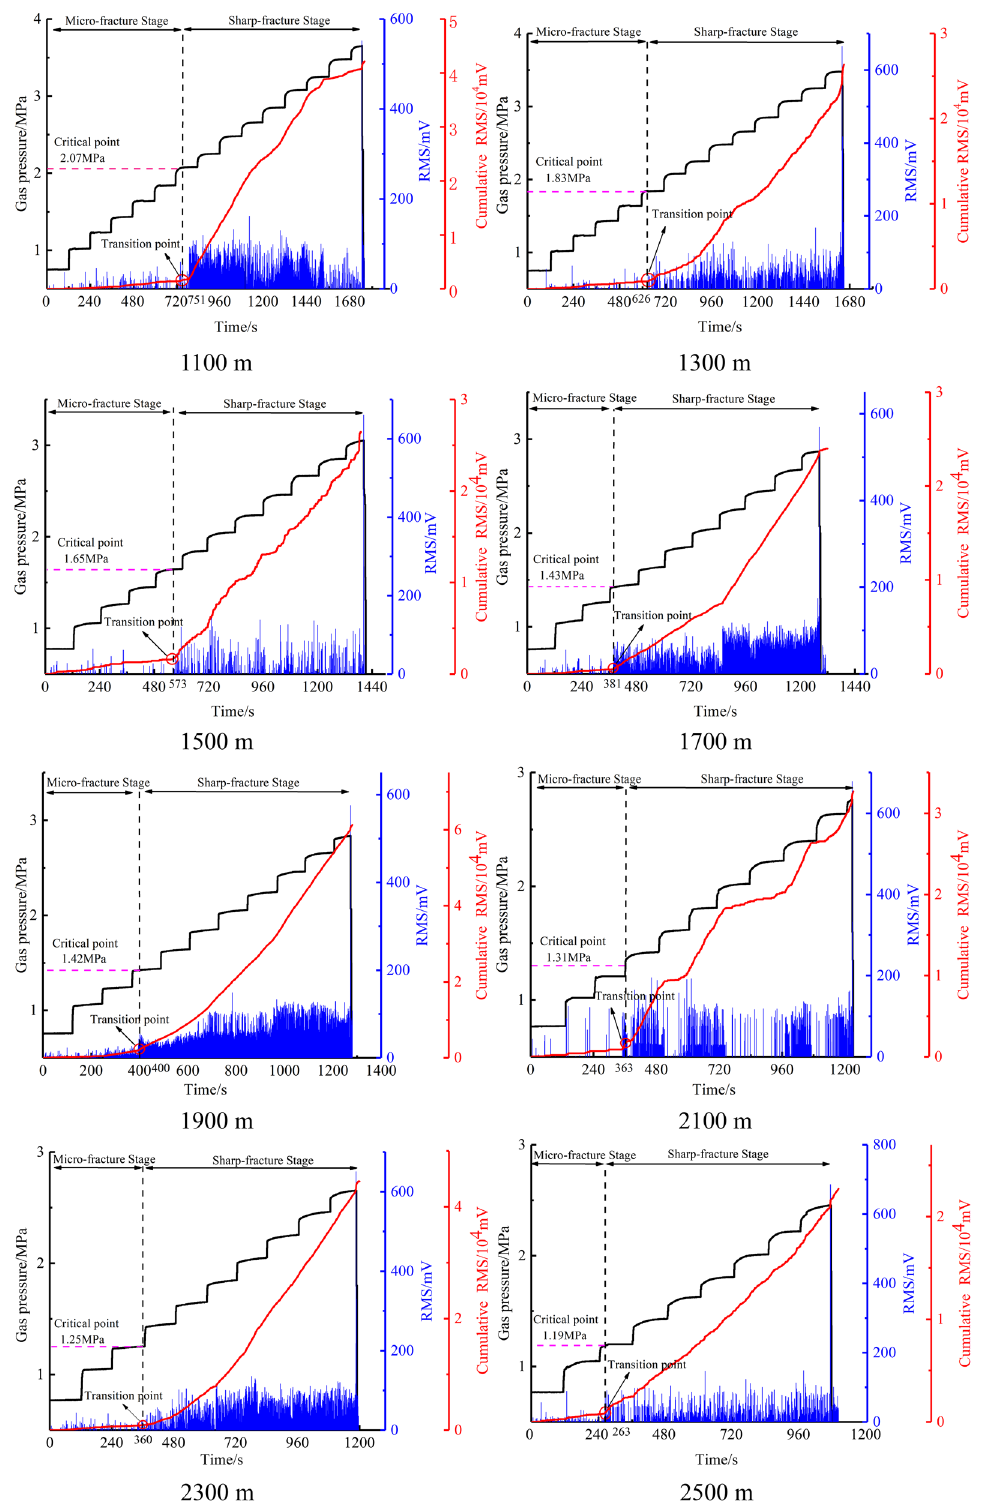
Fig. 4 Evolution of RMS and cumulative RMS with gas pressure at different